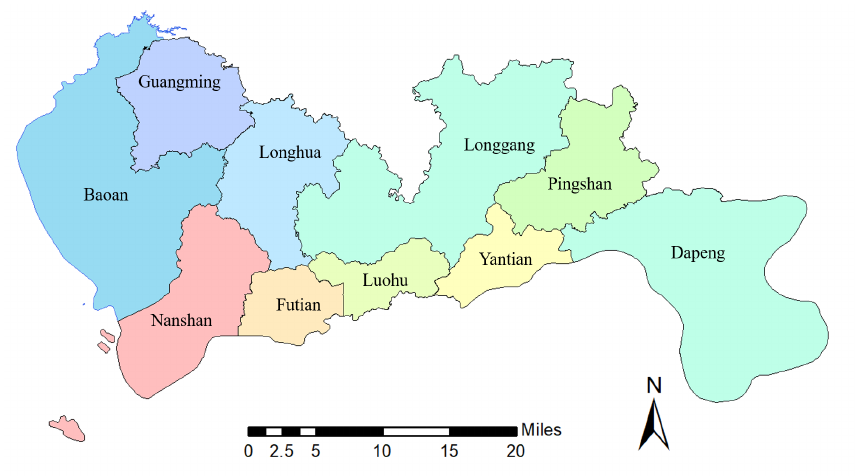
Figure 1. The administrative divisions of each district in